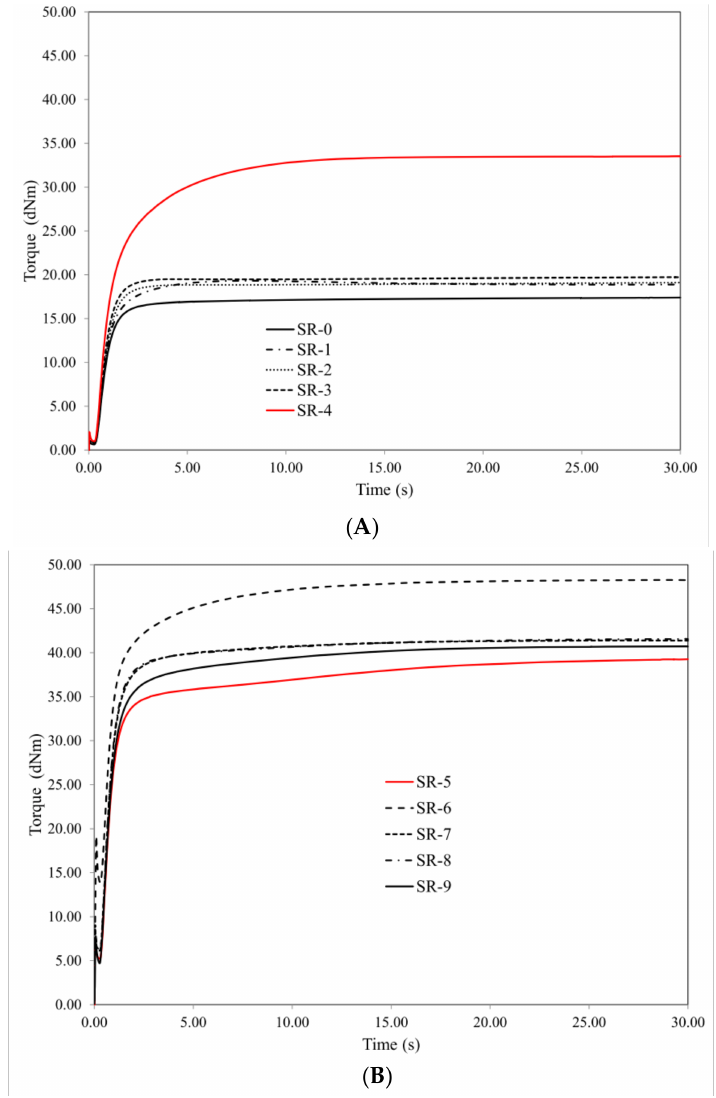
Figure 2. Vulcanization kinetics: ( A ) composite mixes, ( B ) ceramizable composite